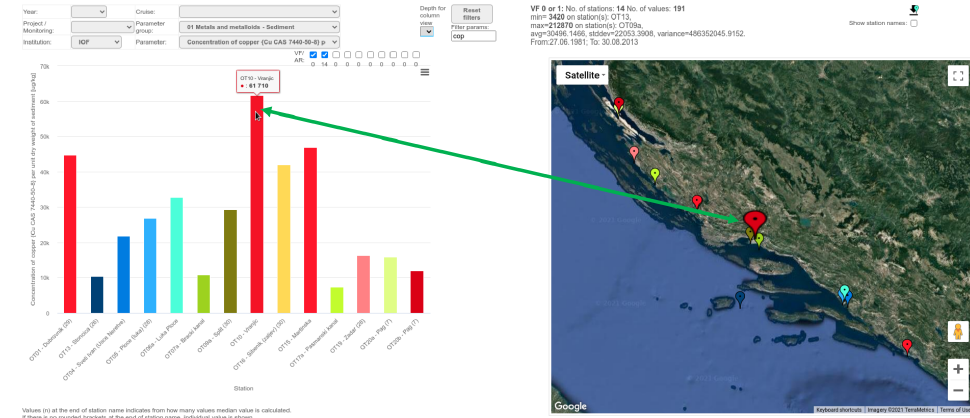
Figure 8. Example of bidirectional connection from web